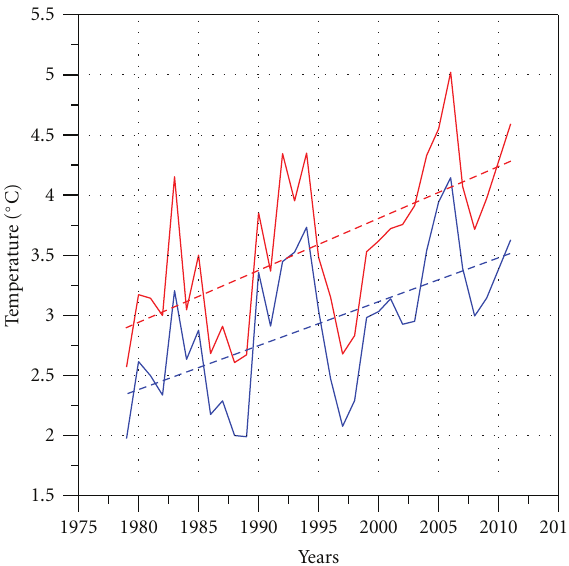
Figure 7: Water temperature in the core of the West Spitsbergen current at 79 ◦ N; red: 100–200 m layer; blue: 200–300 m layer.